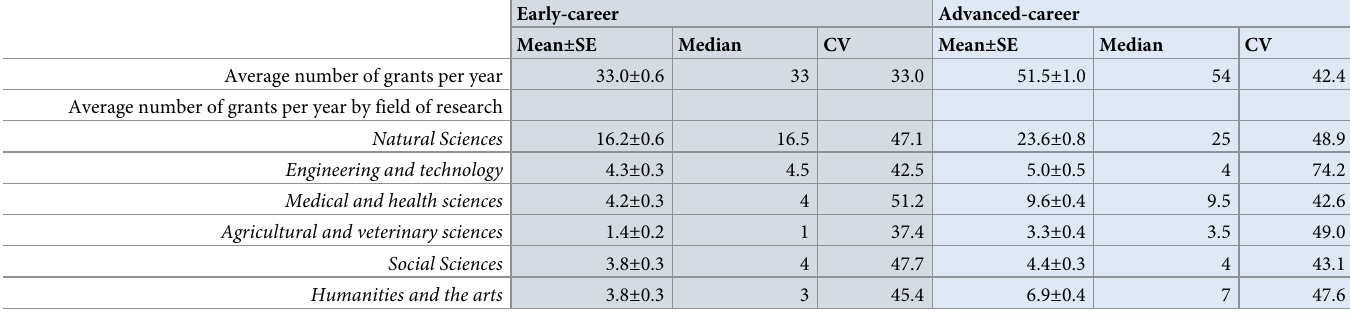
Table 2. Information of the number of grants, distribution of gender and fields of research across grant types (early/advanced) for grants awarded by the Estonian Research Council between